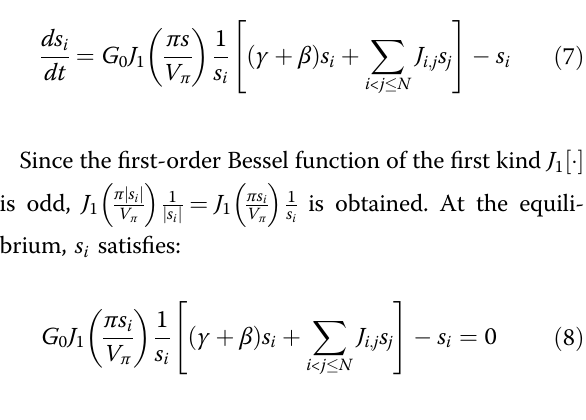
, i,j σ σ < 0) i,j i j